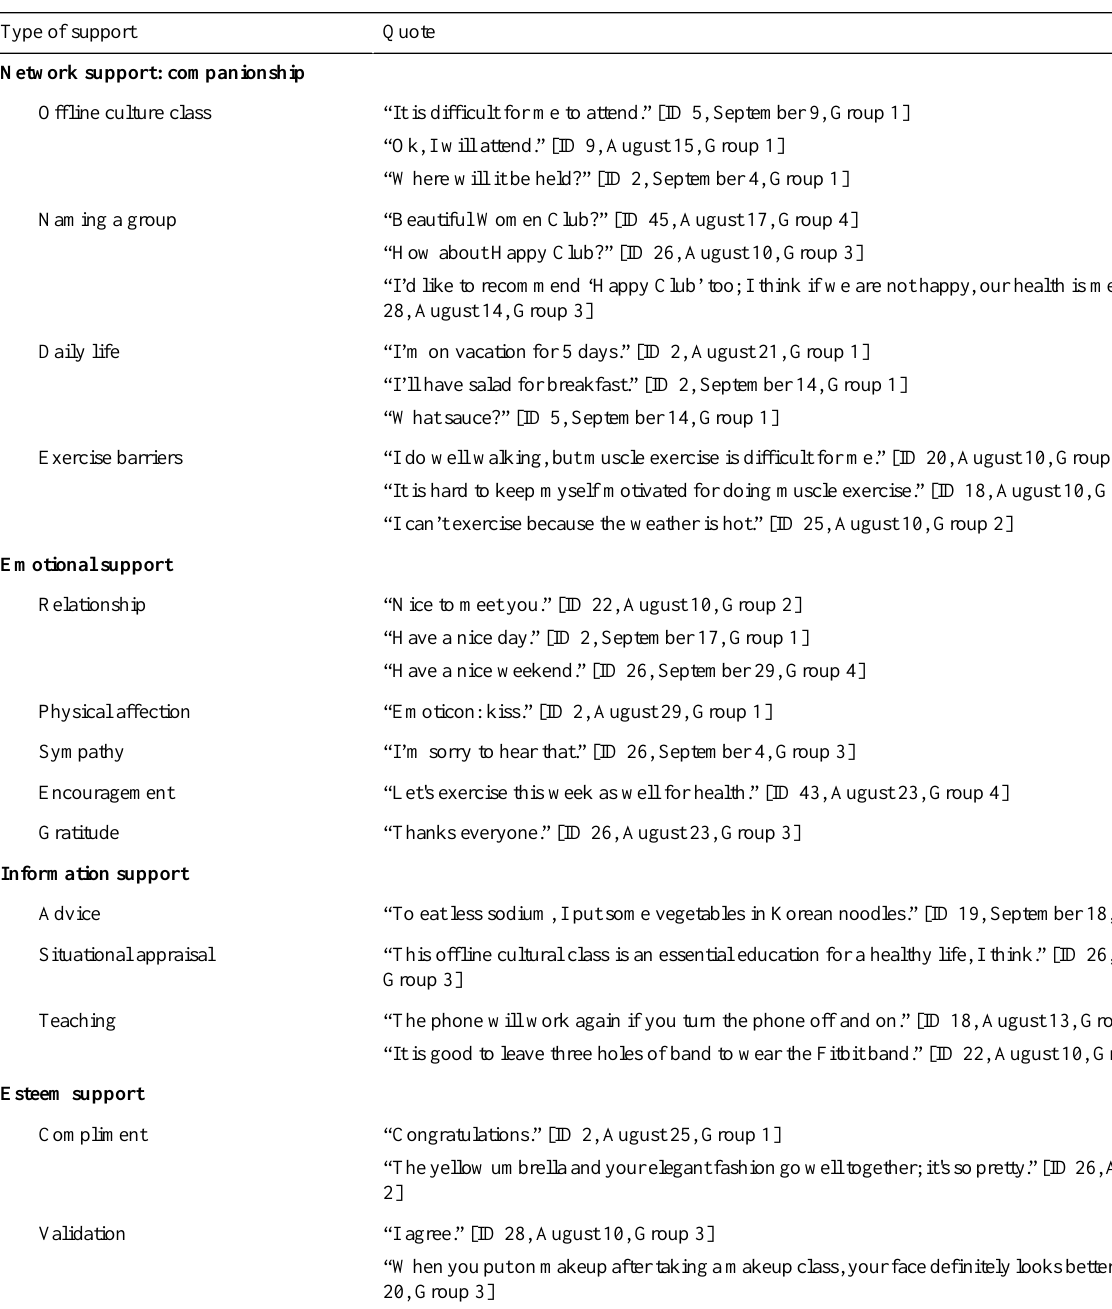
Table 2. Example quotes from messages of each type of social